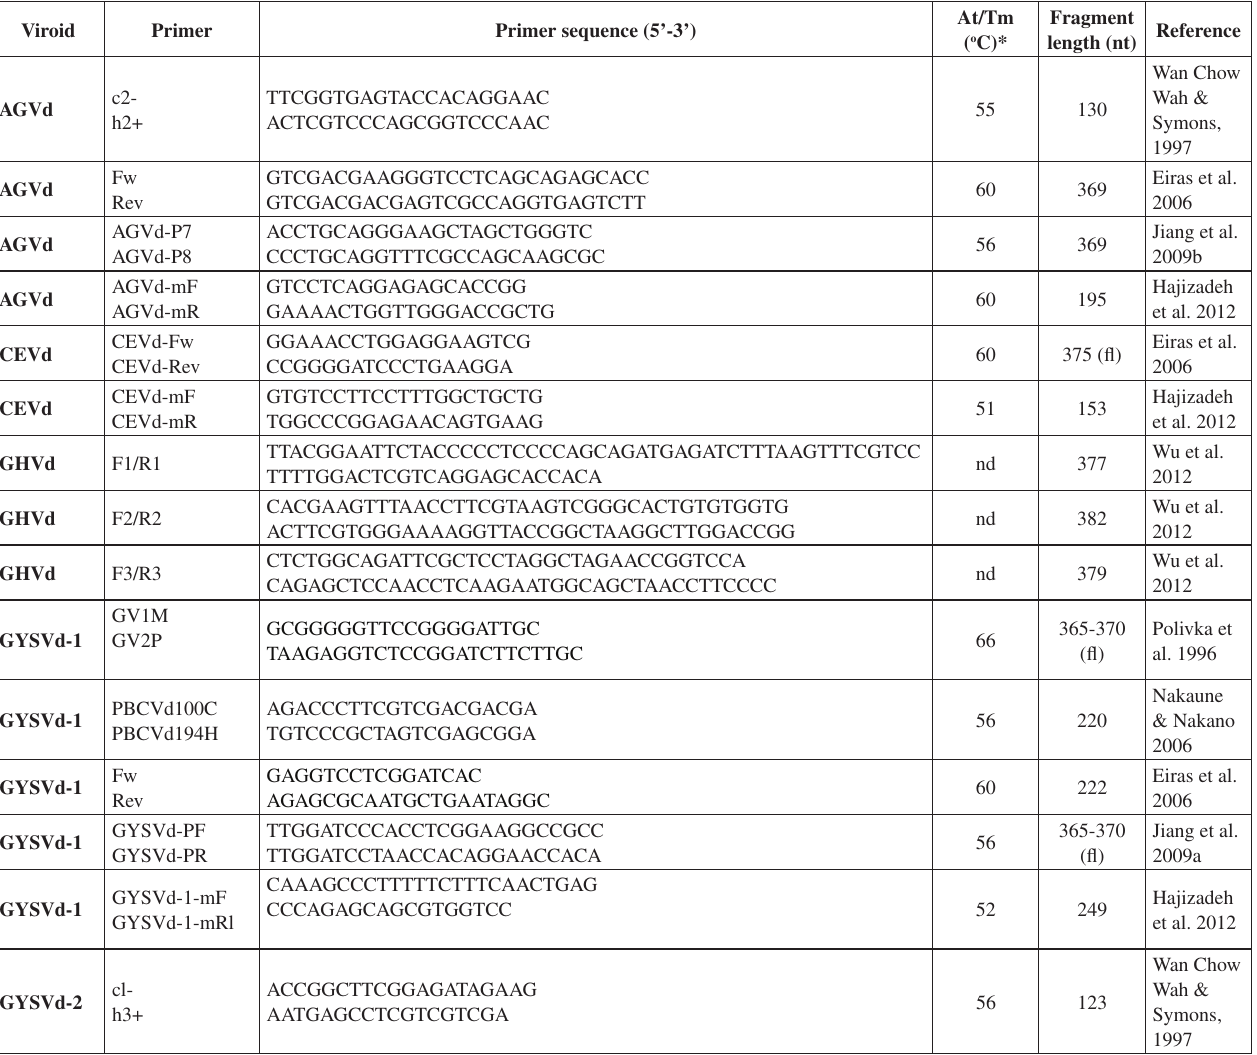
Table 1. Viroid-specific